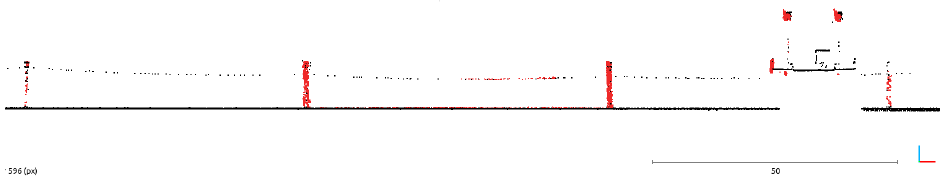
Figure 20. Cross section of scan obtained with designed system (red color) and DEM (black color).